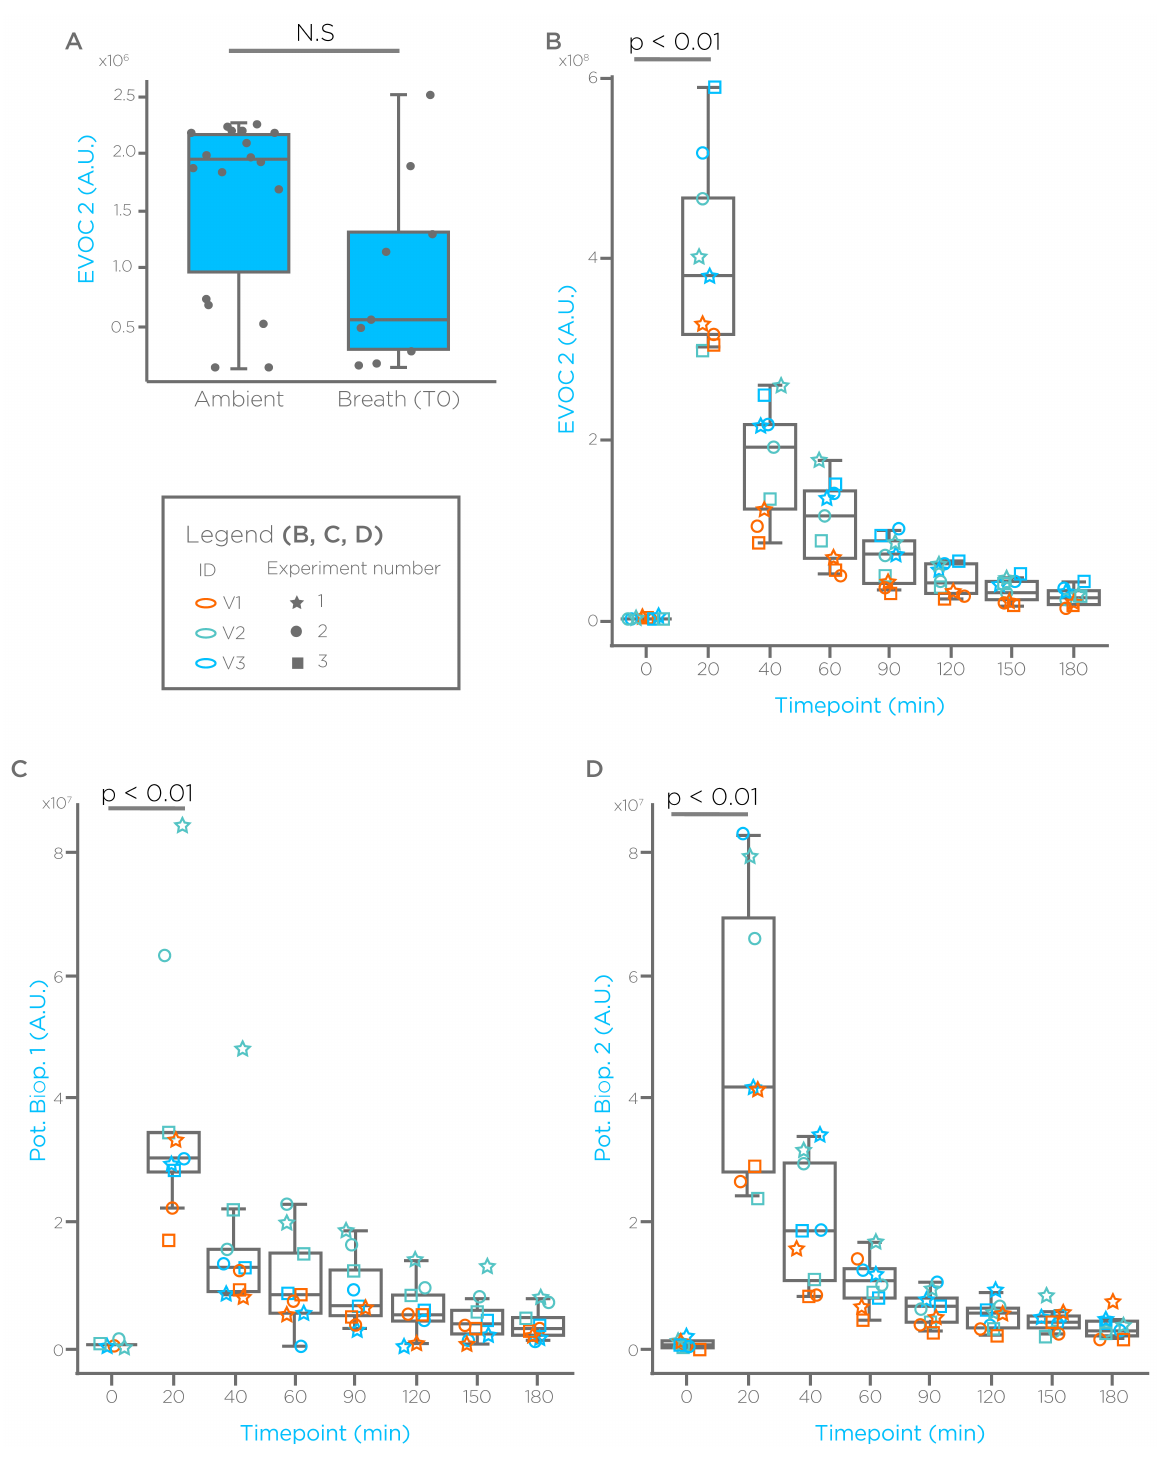
Figure 2. EVOC 2 breath profile. ( A ) Levels of EVOC 2 in ambient and breath from 3 healthy subjects fasted for ≥ 10 h. ( B ) EVOC 2 profile on breath before and after administration at the indicated time points. ( C , D ) Spectral features representing potential EVOC 2 bioproducts (Pot. Biop.). A.U. = arbitrary